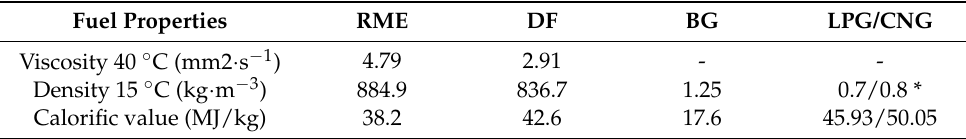
Table 4. Physical properties of liquid and gaseous fuels.